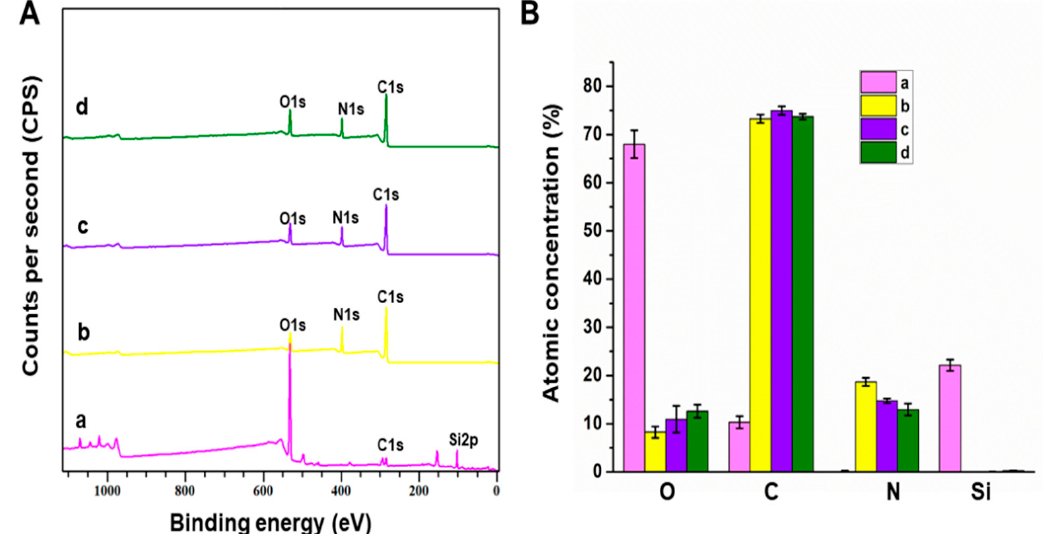
Figure 3. ( A ) X-ray photoelectron spectroscopy survey spectra and ( B ) atomic concentration of elements such as O, C, N and Si of a—OB, b—OB-POX, c—OB-POX/L-Trp, d—OB-POX/D-Trp.